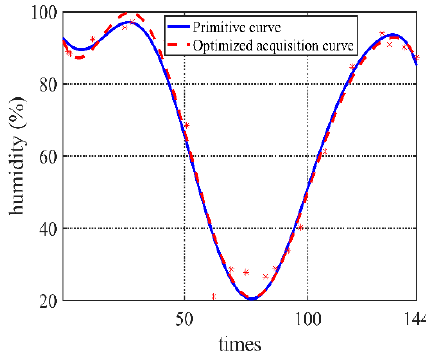
Figure 12. Algorithm humidity collection and the real data.